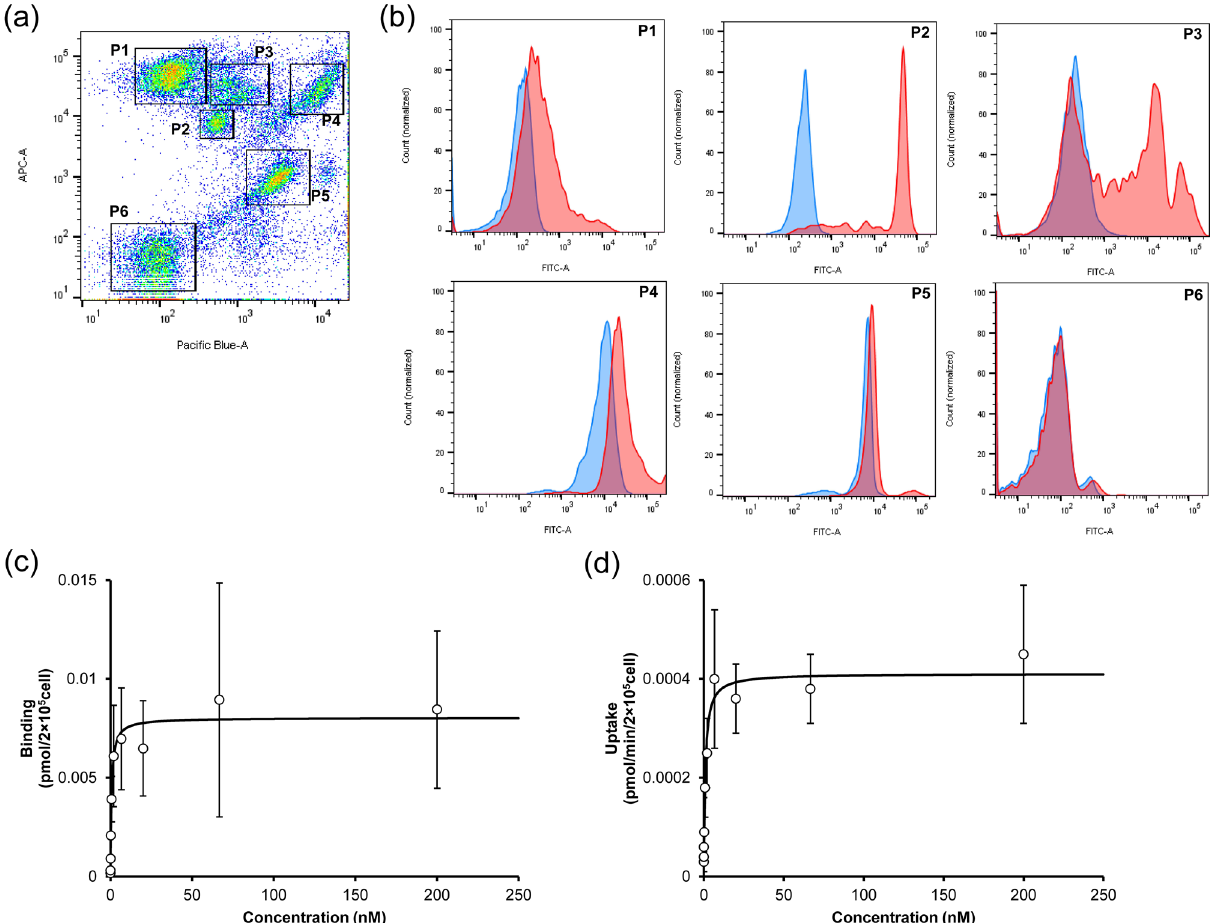
Figure 5. Cellular binding and internalization assay using monkey NPC. ( a ) Cellular dot plot after staining with CD31 and CD45. X axis (Pacific Blue) and Y axis (APC) shows CD31 and CD45, respectively. CD31 low/CD45 high, CD31 mid-low/CD45 mid-high, CD31 mid-low/CD45 high, CD31 high/CD45 high, CD31 mid-high/CD45 mid-low, and CD31 low/CD45 low population were named as P1, P2, P3, P4, P5, and P6, respectively. ( b ) Histogram of the FcγRIIB expression in each population. X axis (FITC) shows the fluorescence of Alexa Fluor 488. Red shows staining with anti- FcγRIIB antibody and blue shows unstaining. ( c )